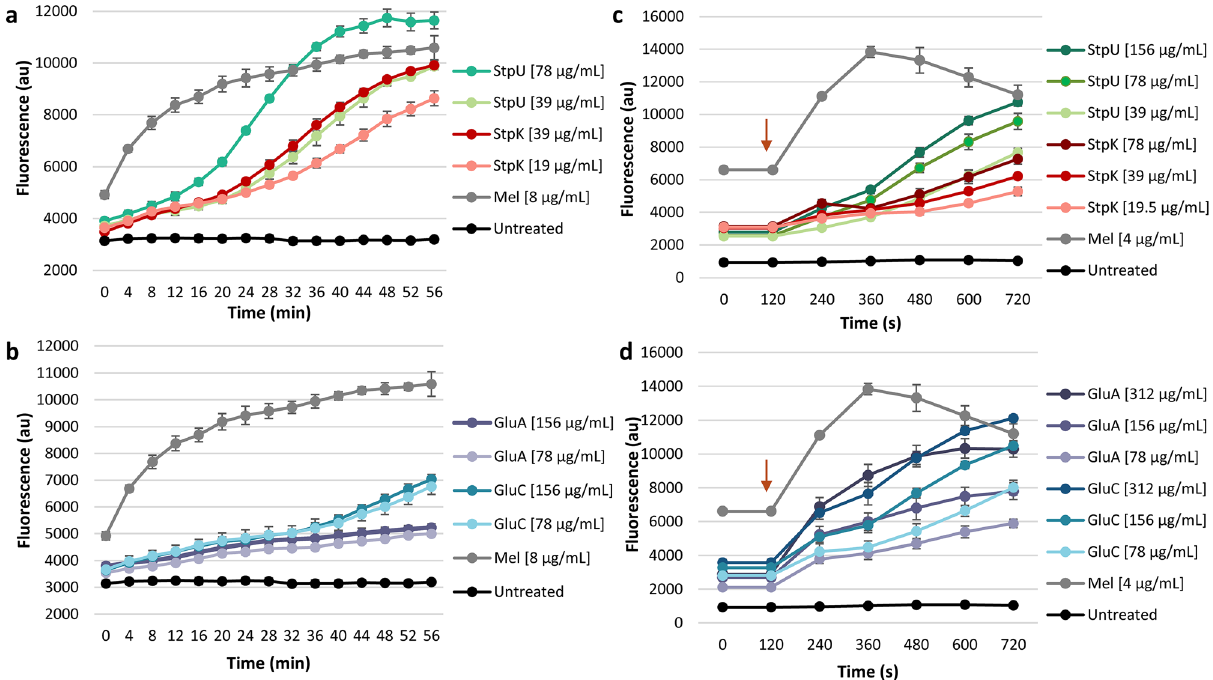
Figure 5. Membrane permeability of S. aureus RN4220 incubated with PI in the presence of ½MIC and MIC of ( a ) StpU and StpK [ m/z 682 ( 12 ) and 684 ( 14 ), respectively] and ( b ) GluC and GluA [ m/z 559 ( 22 ) and 585 ( 26 ), respectively]. Membrane potential measurements of exponentially growing S. aureus RN4220 cells incubated with DiSC 3 (5) in the presence of ½MIC, MIC and two-fold MIC of ( c ) StpU and StpK and ( d ) GluC and GluA. Melittin (Mel; ≥ 85%) served as a positive control and untreated cells served as negative control. au—arbitrary units. The red arrow indicates the first reading after cells were